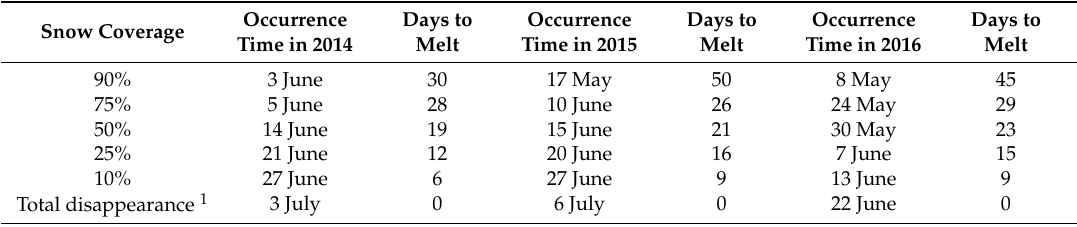
Figure 6. Evolution of SCE in Fuglebekken catchment obtained from the time-lapse camera images in spring ( a ) 2014, ( b ) 2015 and ( c ) 2016; each blue point represents a classified image, daily meteorological data are shown in the background. Table 4. Time needed to fully melt the snow cover starting from different SCE values in the period 2014–2016. Dates for specific SCE were interpolated in case of missing